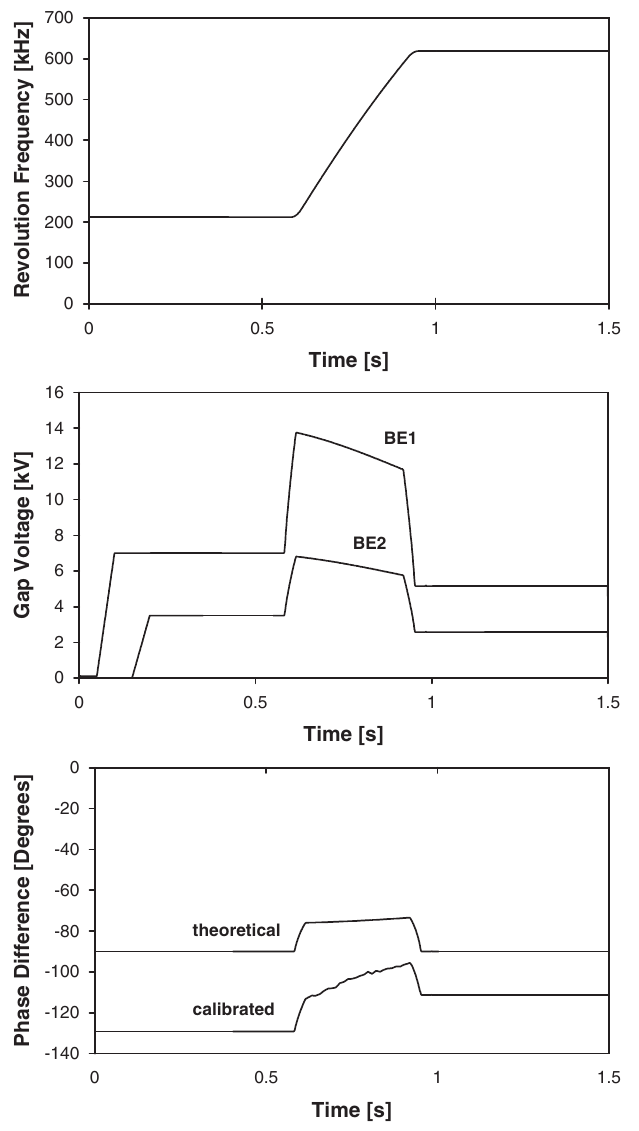
FIG. 8. Ramps for dual-harmonic acceleration (uppermost trace: revolution frequency; trace in the middle: gap voltages; bottommost trace: phase